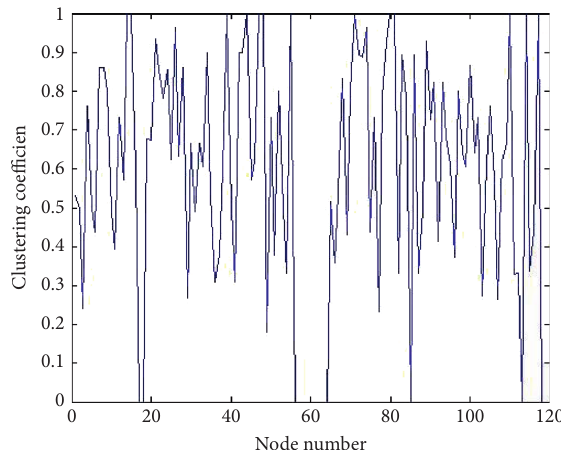
Figure 6: Clustering coefficient.